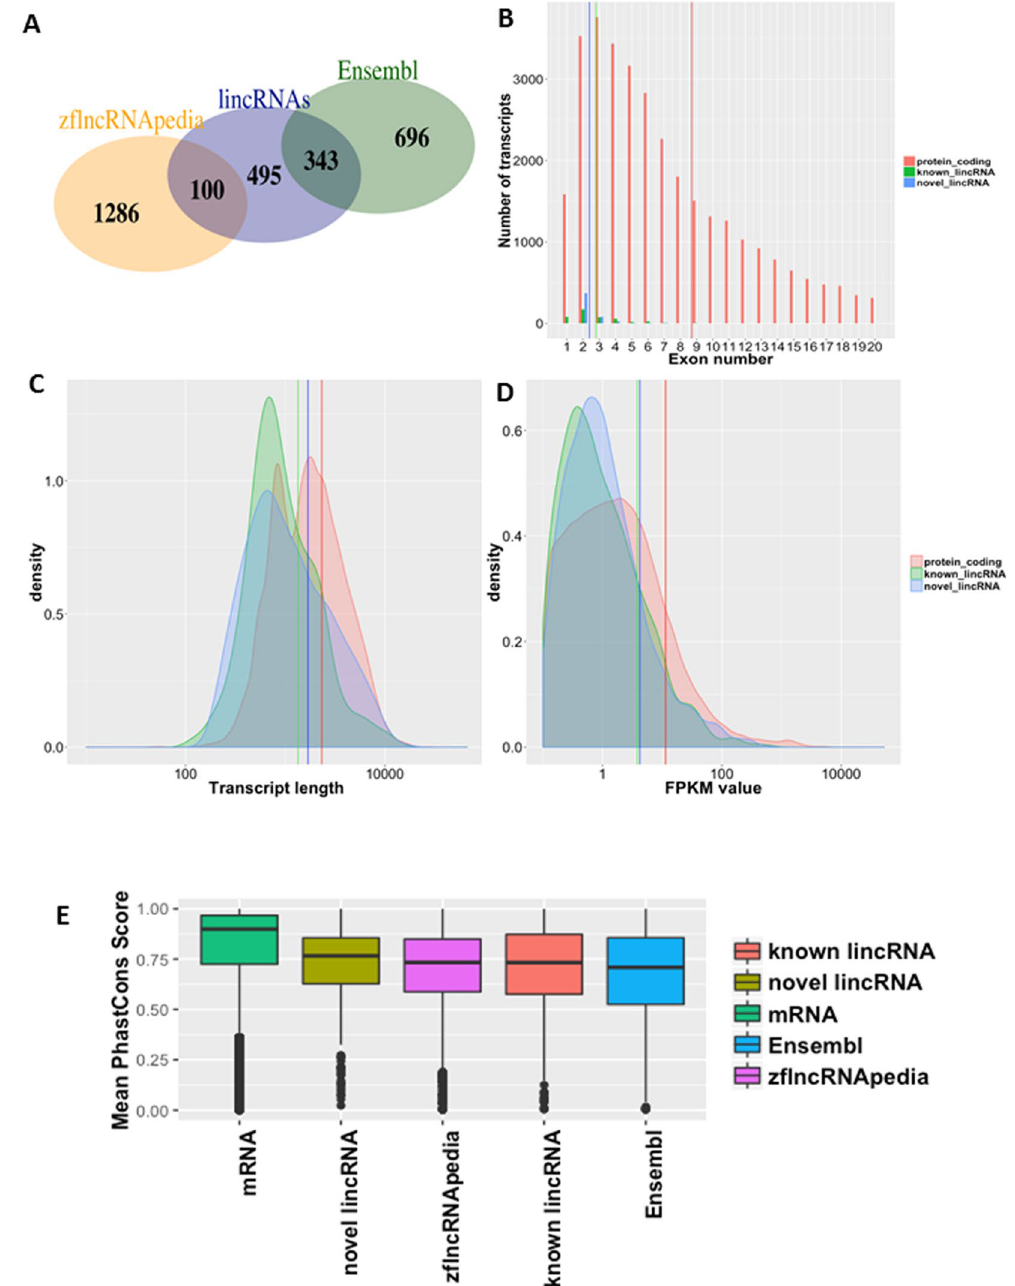
Figure 2. Zebrafish lincRNAs are shorter, less conserved, and expressed at lower levels than protein-coding genes. ( A ) Overlap among cardiac lincRNAs (dark blue) and other existing annotations: Ensembl (dark green), and zflncRNApedia (orange). Distribution of exon numbers ( B ), transcript length ( C ), expression level ( D ), and phastCons scores ( E ) for protein-coding genes, previously annotated lincRNAs, and novel lincRNAs in our RNA-seq